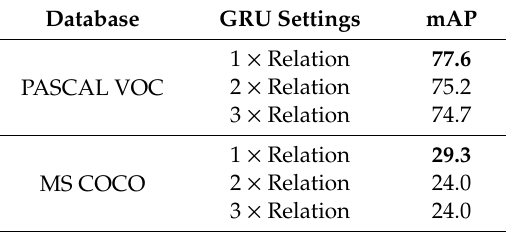
Table 9. Comparison of different relation module settings. K × Relation denotes with K connected relation modules. The bold characters represent the best result for each column.